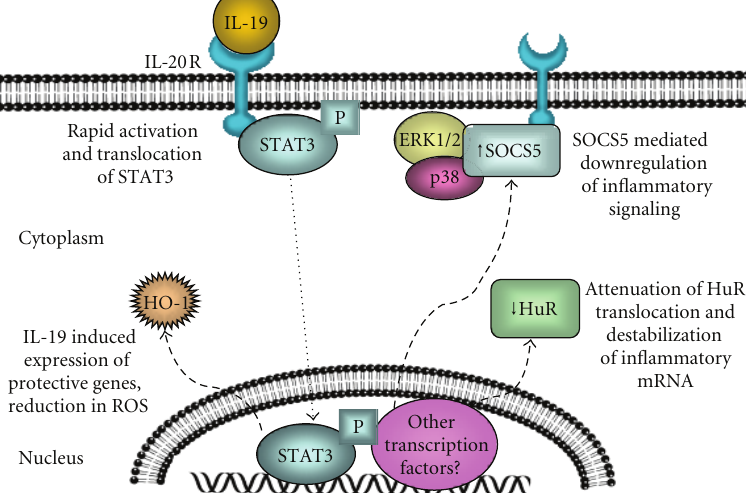
Figure 1: Proposed pleiotropic mechanisms of IL-19 e ff ects in vascular smooth muscle cells. Several mechanisms occurring independently or concurrently may be responsible for IL-19 anti-inflammatory e ff ects on VSMC. These include STAT3-mediated SOCS5 expression, which dampens early activation events such as signal transduction. The second is a down-regulation of HuR abundance and cytoplasmic translocation, resulting in attenuation of proliferative and inflammatory gene expression. The third is expression of HO-1, with subsequent protective e ff ects attributed to HO-1 such as reduction of intracellular ROS. These mechanisms are not mutually exclusive, so varying degrees or combinations of each are